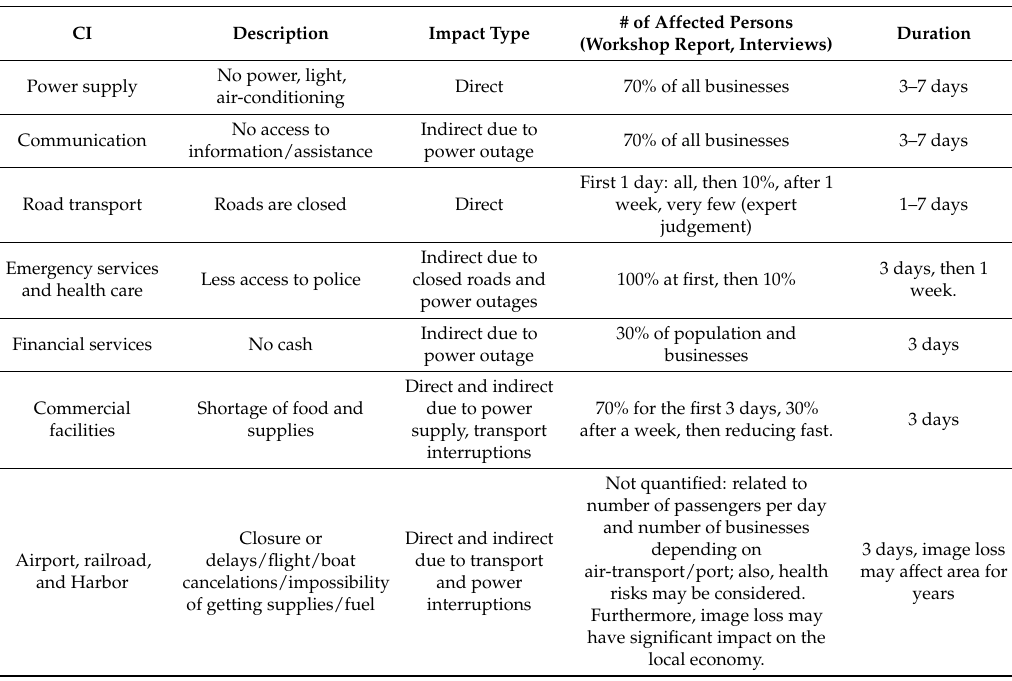
Table 3. Most relevant business impacts.